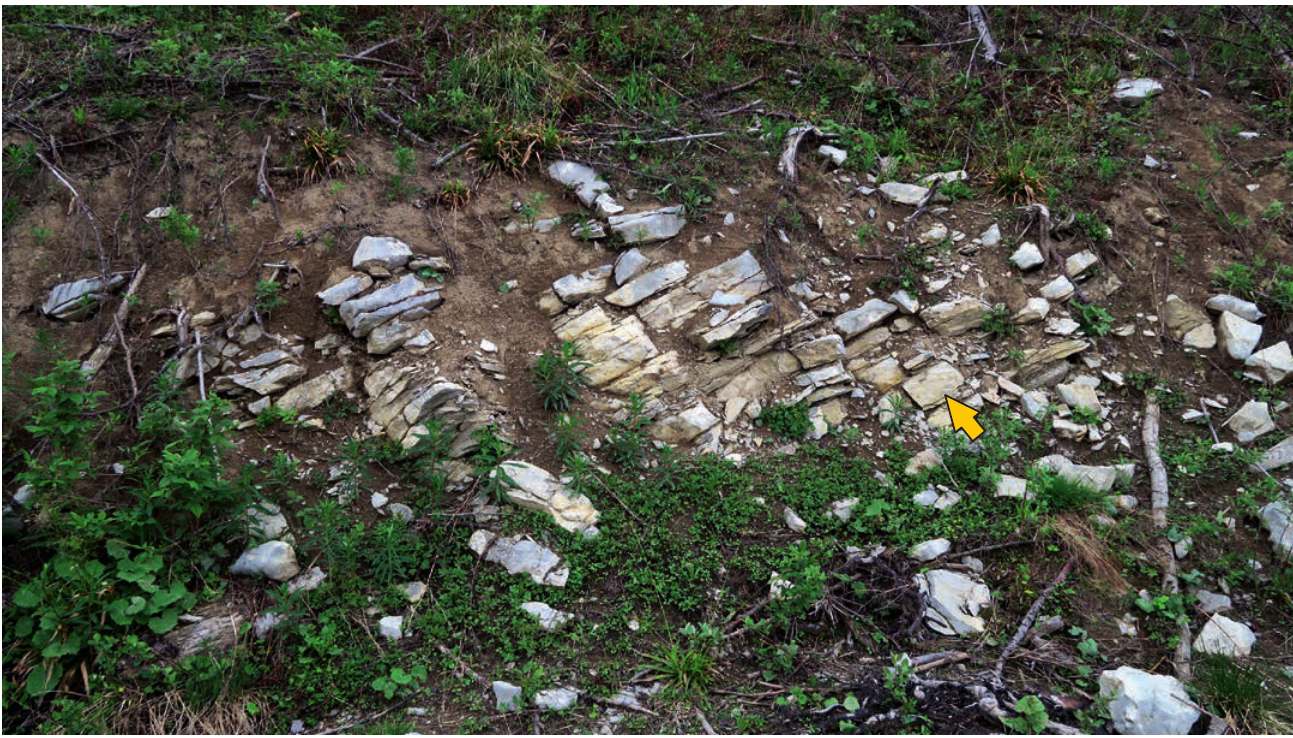
Fig. 2. Outcrop of the Lower Cretaceous sequence of the Kościeliska Marl Formation, the Western Polish Tatra Mountains (arrow indicates approximate location of collected samples). Photo taken by Andrzej Gaździcki, 3 August